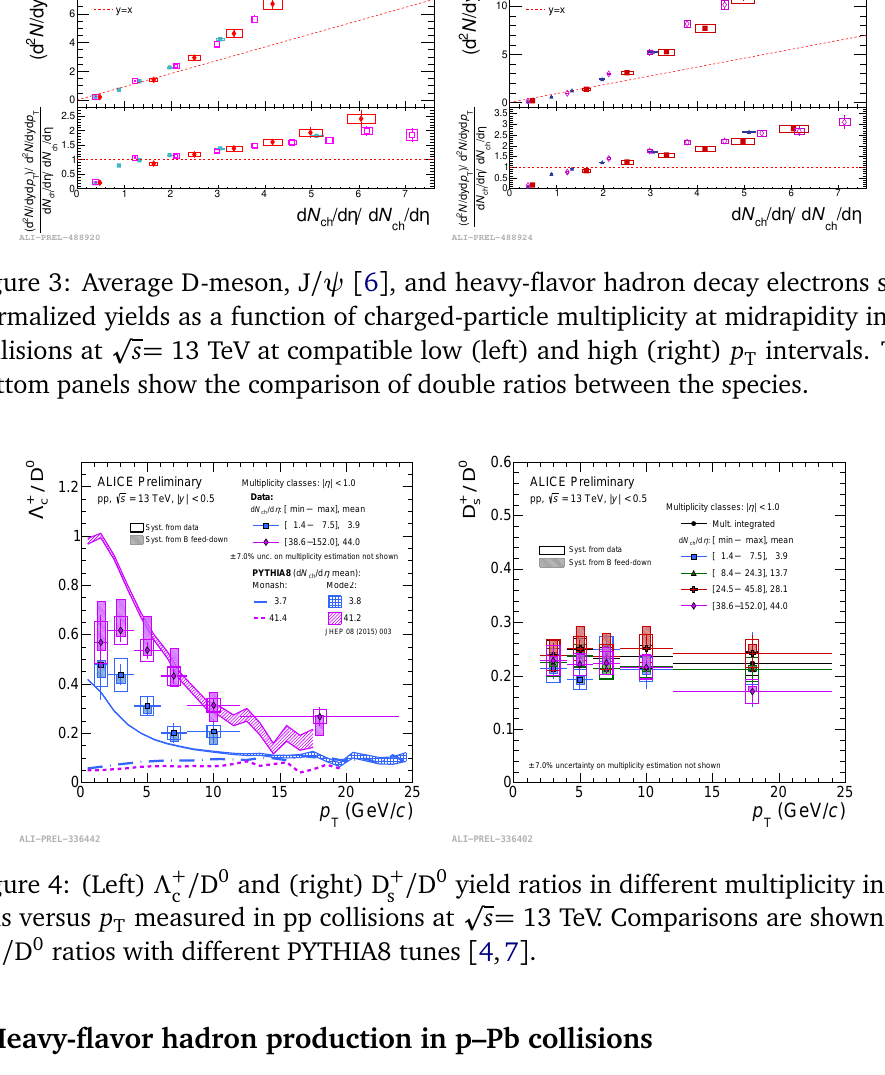
/ D 0 yield ratios in different multiplicity inter- (cid:112) s s = 13 TeV. Comparisons are shown for